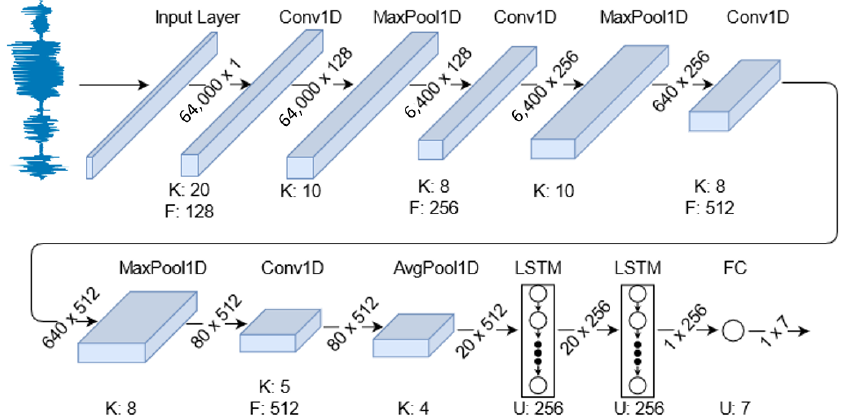
Figure 2. The architecture of the proposed 1D CNN + LSTM-based deep neural